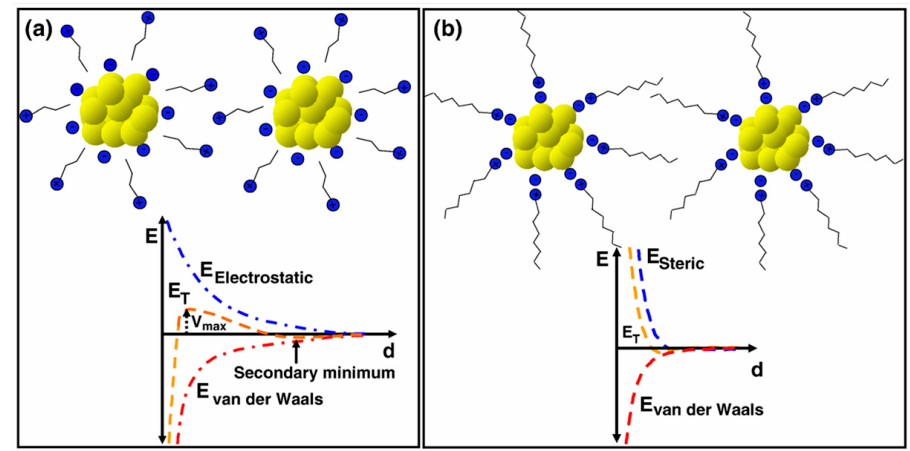
Figure 5. Stabilization of nanoparticles in a dispersing medium; ( a ) electrostatic stabilization and ( b ) steric stabilization of metal. Reprinted with permission from Ref. [89]. Copyright 2004,